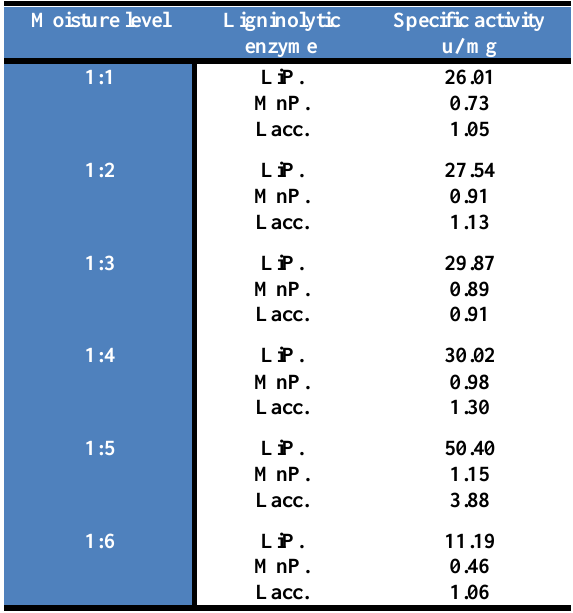
Table, 5: Ligninolytic enzymes production in different moisture level.